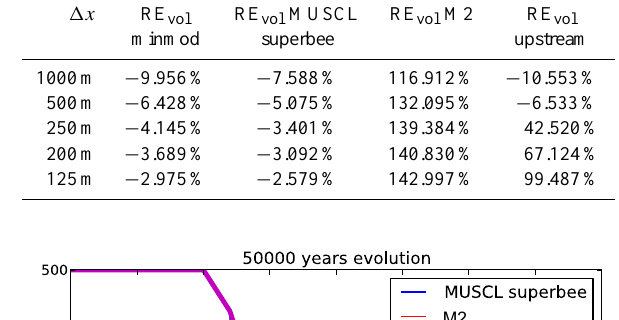
Fig. 3. Comparison of the “MUSCL superbee” scheme (blue lines) with a classical “M2” scheme (red lines), an upstream scheme (green lines), and a solution computed with Eqs. (56) and (57) (orange line). For all numerical schemes, solutions are plotted at 1000yr intervals for a 50000yr evolution.